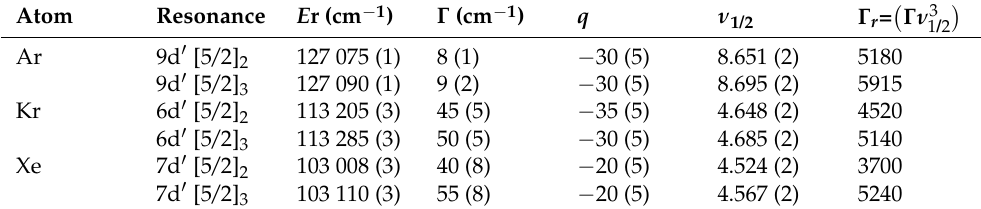
Figure 13. The 3p 5 ( 2 P 1/2 )nd [5/2] 3 Rydberg series excited from the 3p 5 4p’ [3/2] 2 intermediate level in argon. The nd series is dominating in intensity, as compared with the ns series. Table 8. Line profile analysis of the autoionizing resonances in Ar, Kr, and Xe.